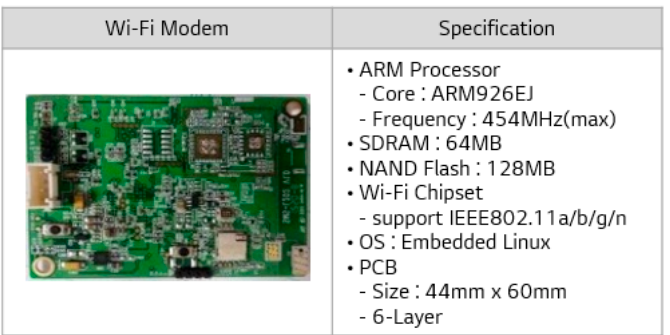
Figure 8. Wi-Fi modem and its specification used for experiments.